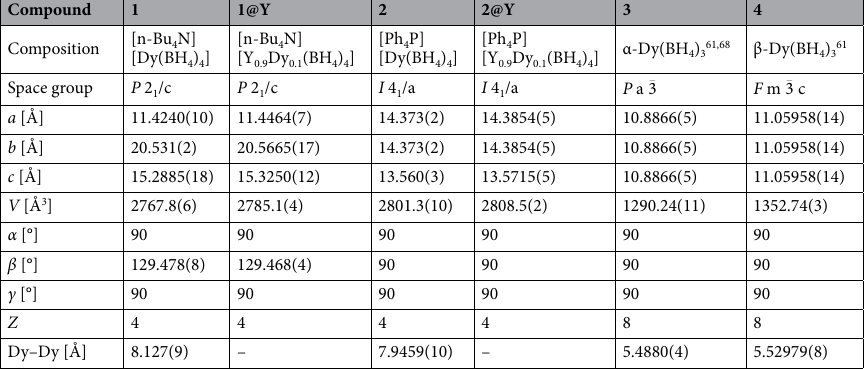
Table 2. Crystal data of 1 and 2 , and their Y-diluted analogs, compared with the reported 3 and 4